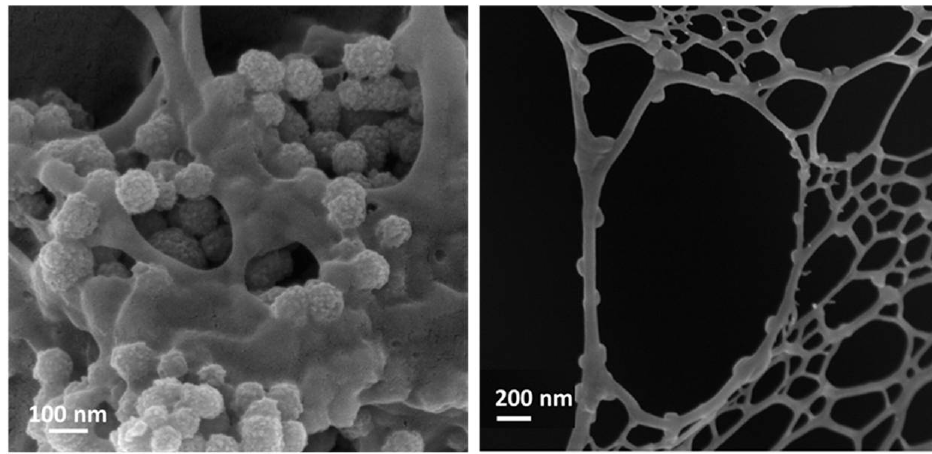
Figure 6. Field emission scanning and electron microscopy (FESEM) images of type I collagen containing Sr-MBG nanoparticles. Reproduced (adapted) from reference [123]. Copyright 2020 MDPI.